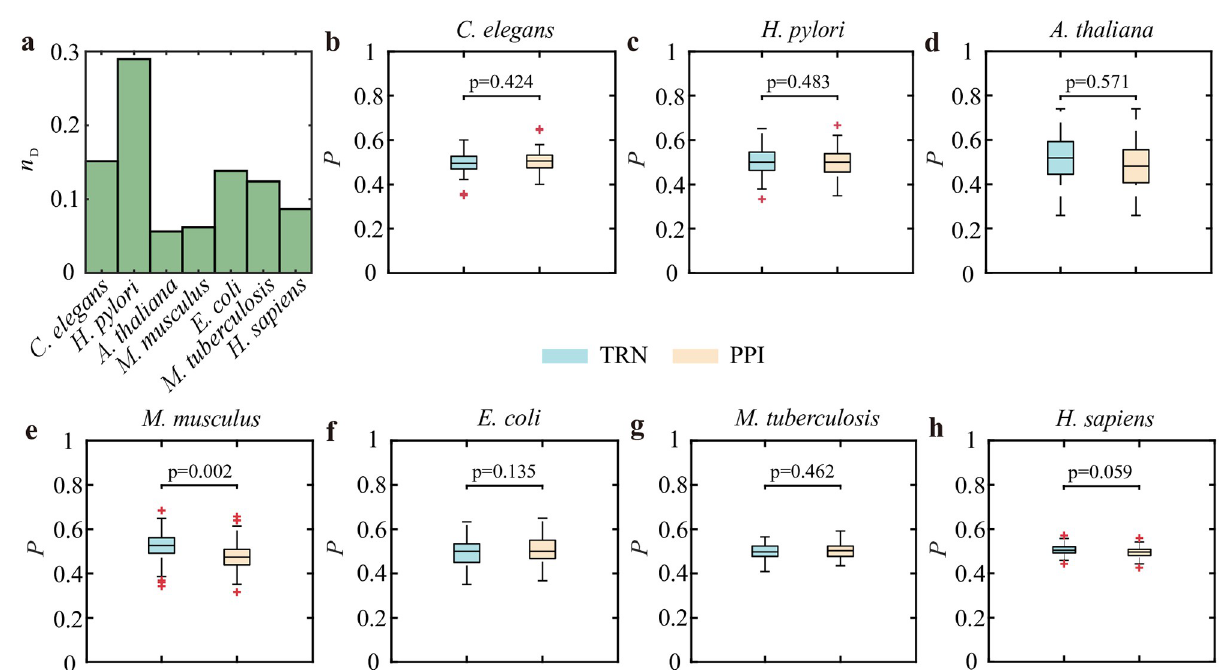
Fig 2. Controllability and driver node distributions of TRN-PPI multiplex networks. (a) The fractions of minimal driver nodes for seven species. (b)-(h) are the fractions of the minimal driver nodes in two layers for (b) C. elegans , (c) H. pylori , (d) A. thaliana , (e) M. musculus , (f) E. coli , (g) M. tuberculosis , and (h) H. sapiens . We obtain 100 minimal driver node sets and calculate the average values of the driver node fractions in the two layers. The p-value is calculated by the t-test.